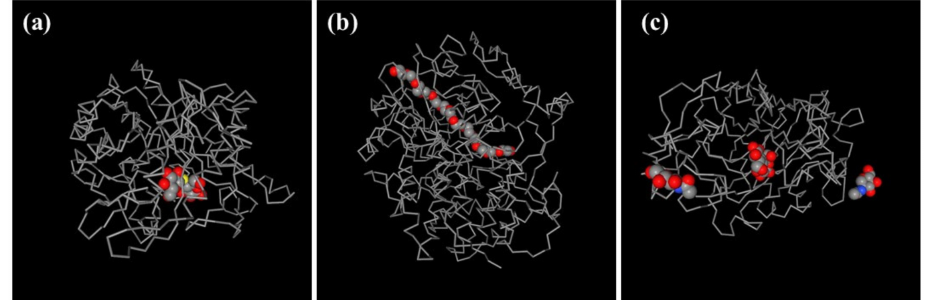
Figure 10. Backbone structure of ( a ) β -glucosidase B from Paenibacillus polymyxa complexed with thiocellobiose, ( b ) the catalytic domain of exoglucanase CelS from Clostridium thermocellum complexed with polyethylene glycol (PEG), and ( c ) the catalytic domain of endoglucanase I from Fusarium oxysporum complexed with cellobiose (Protein Data